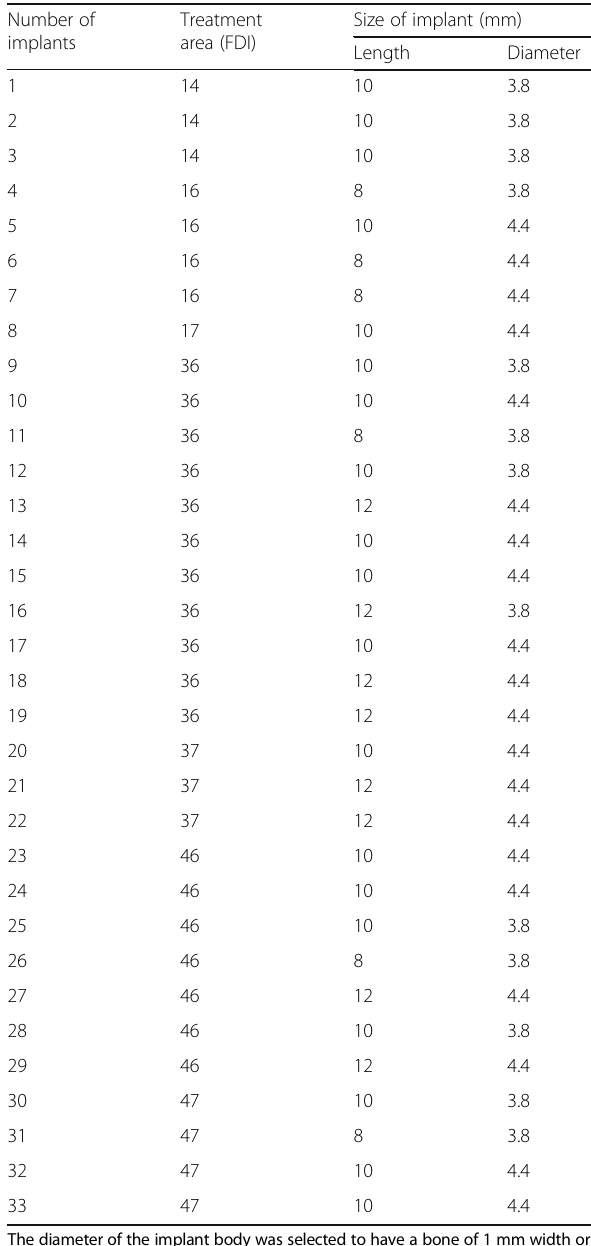
Size of implant